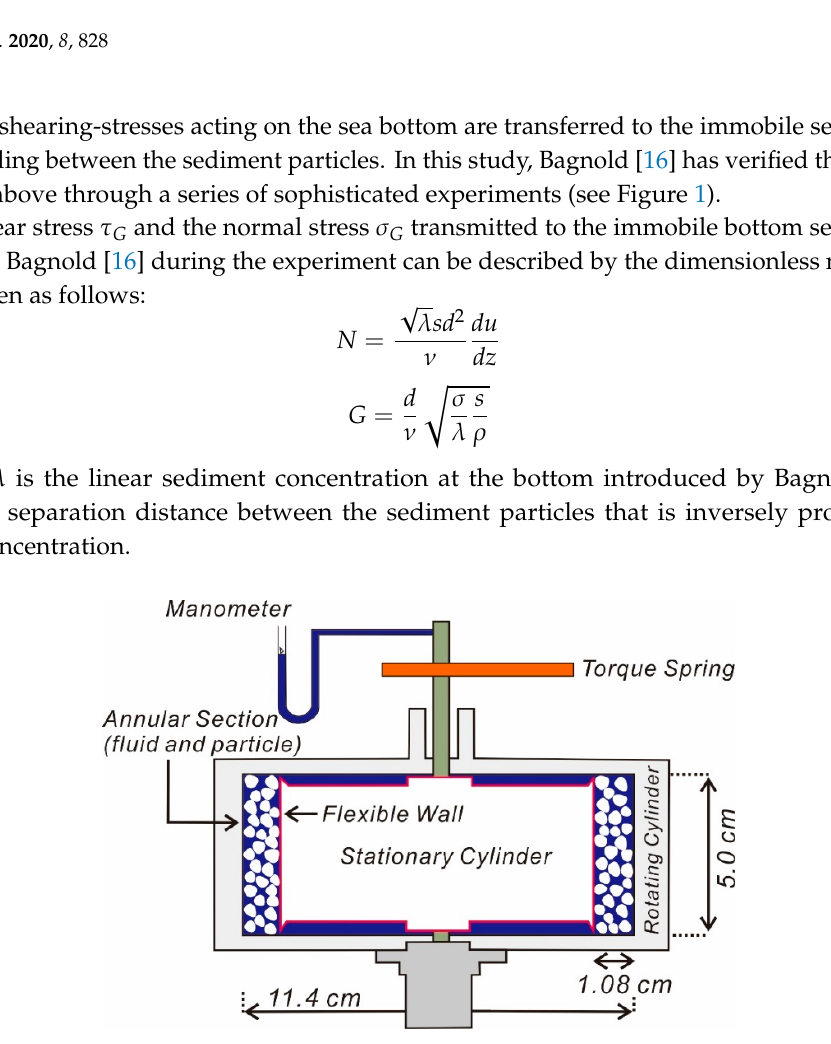
Figure 1. Experimental apparatus used by Bagnold [16] to measure the shear and normal forces in a sheared suspension.